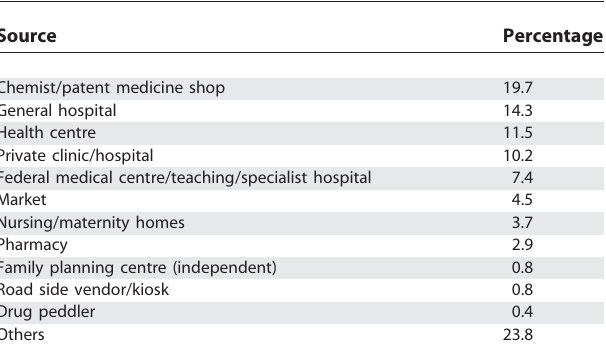
Table 3. Sources of Contraceptive Commodities